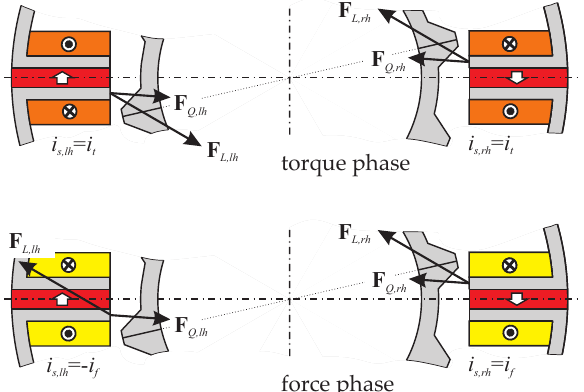
Figure 7. Connection of two opposing coils in series to compensate for the quadratic force component, and to decouple force and